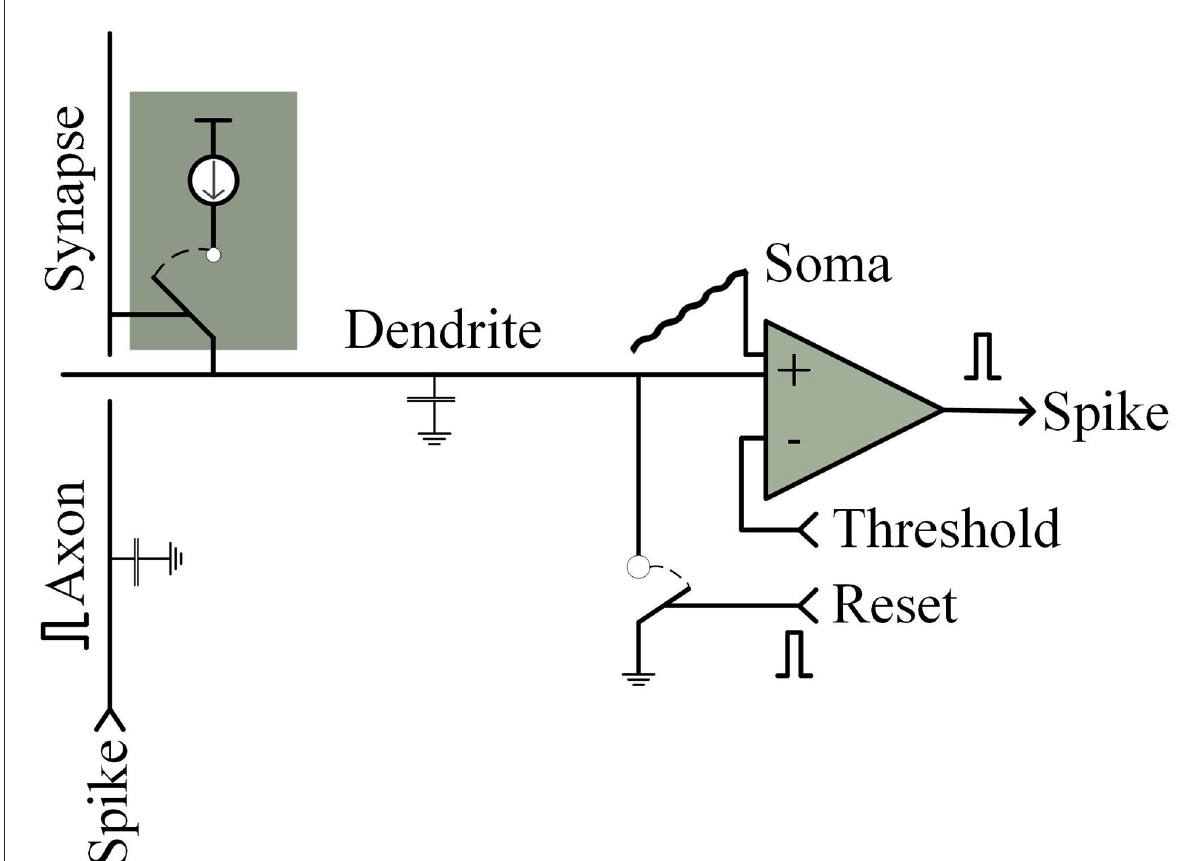
FIGURE9 Analog silicon neurons implementation.